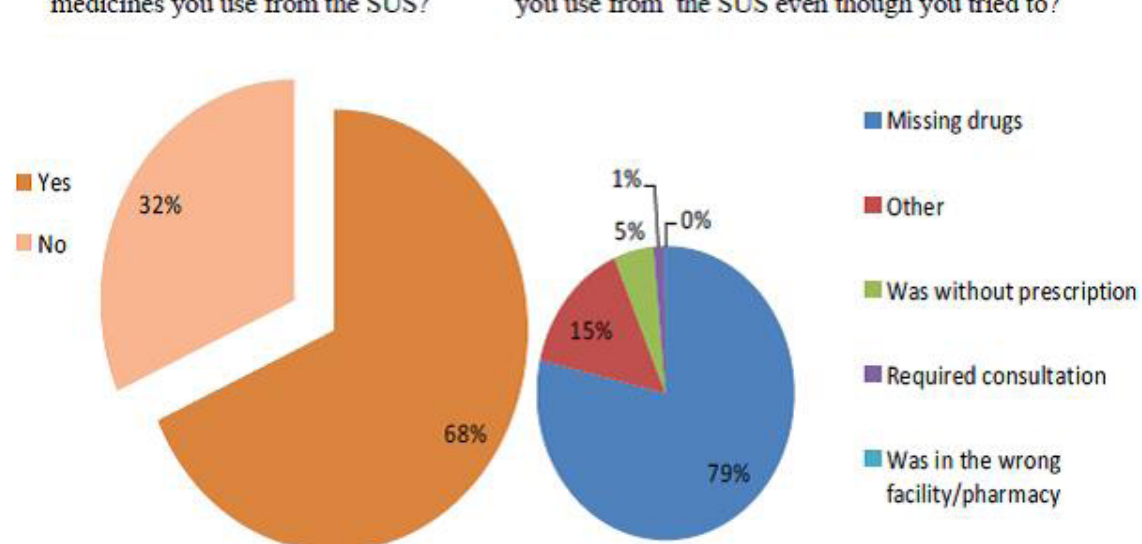
FIGURE 1 – Individuals aged 20 years and over, with at least one chronic illness, with indication of medicines use, who are treated by a physician from the SUS and who said they obtained some of the medicines in use in a private pharmacy. PNAUM, 2014